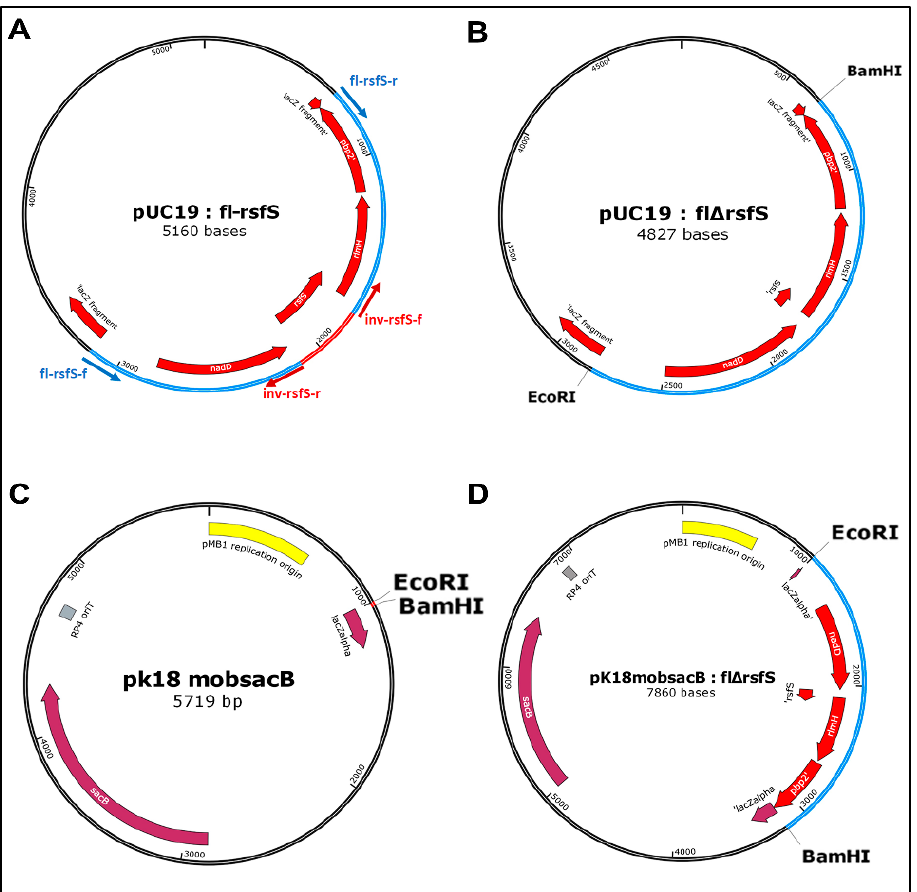
Figure 2. Molecular cloning steps of rsfS gene deletion, where ( A ) is the pUC19 vector with the fl-rsfS insert (blue), ( B ) is the pUC19 vector after deletion of the rsf S gene with the preservation of flanking sequences, ( C ) is the pK18mobsacB vector with EcoRI and BamHI restriction sites, and ( D ) is the pK18mobsacB vector with flΔ rsf S insertion.